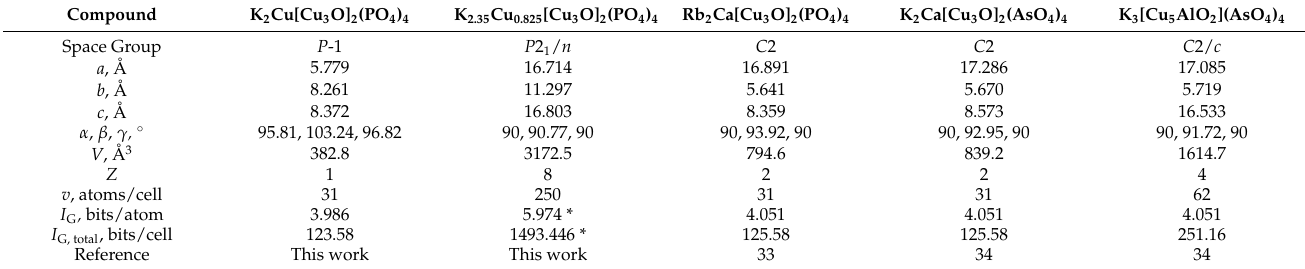
Table 2. Selected crystallographic and structural complexity parameters for shchurovskyite-type structures. Compound